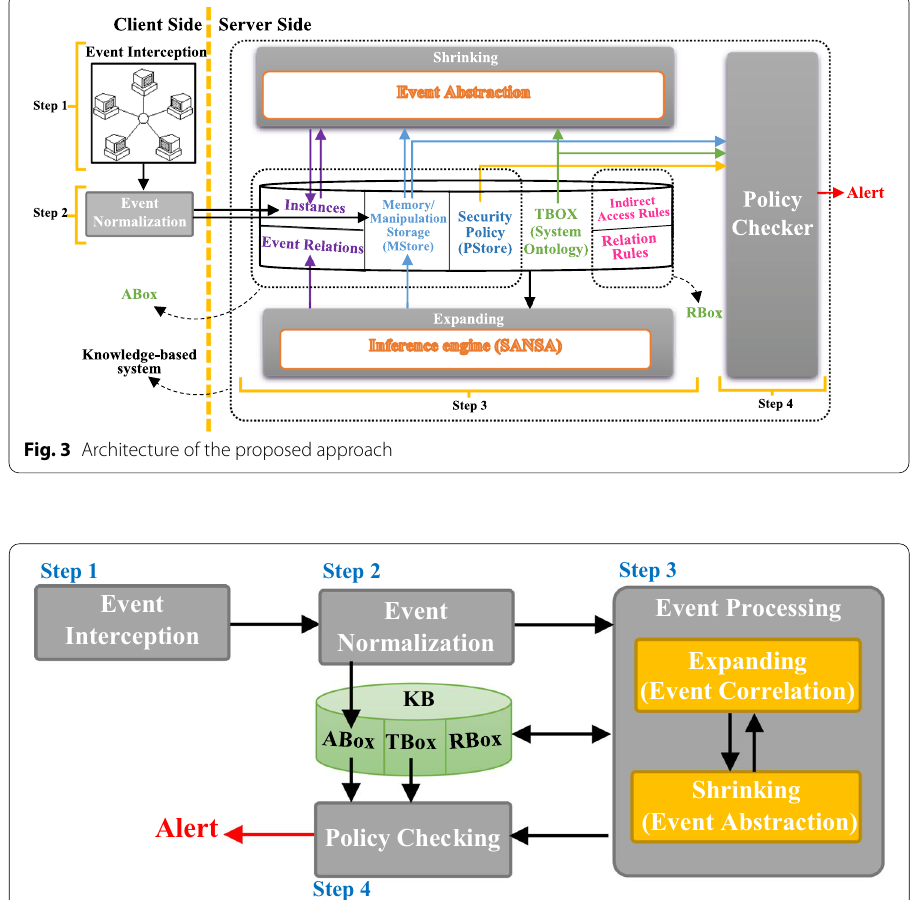
Fig. 4 The detection process based on the proposed